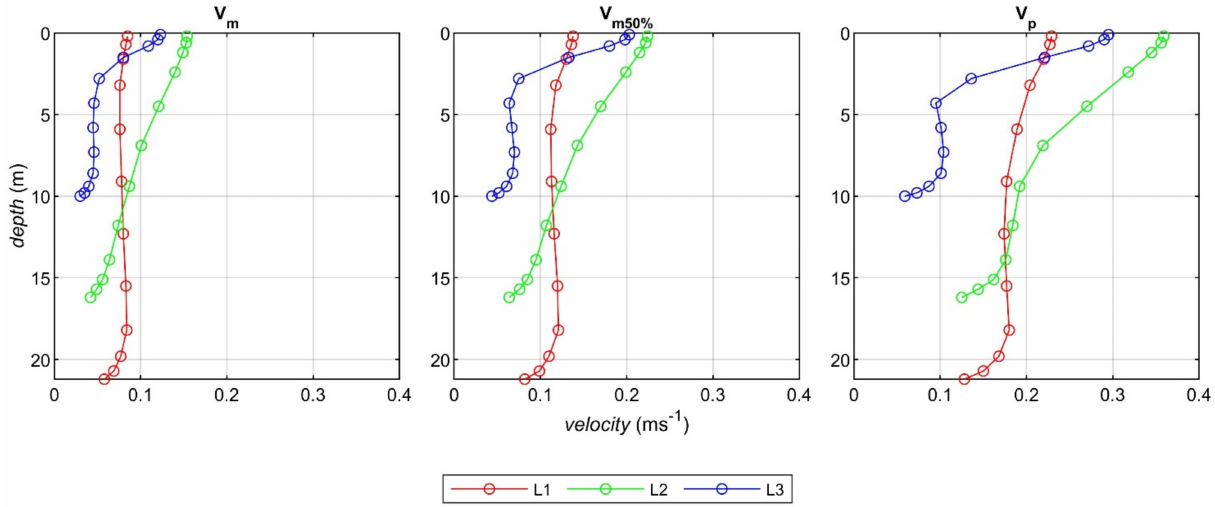
Figure 9. Vertical distribution of the velocity parameters ( V m , V m 50% , and V p ) at the selected repre- sentative locations (L1, L2, and